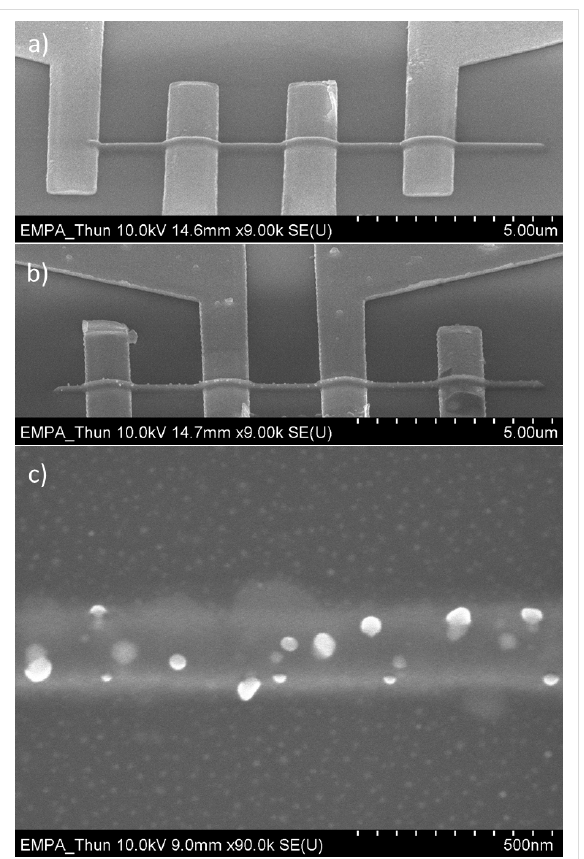
Figure 3: Post-growth annealing of FEBID line from Cu(hfac) 2 between four gold electrodes. SEM tilt images (60°) of a) as-deposited line, b) after annealing at 200 °C for 30 min, and c) top-view zoom into central part of the annealed line showing the Cu nanocrystals on the line deposit and inside as well as on the halo